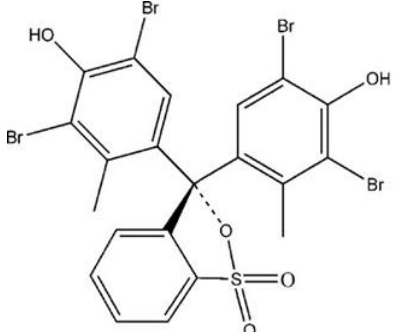
Figure 1. The molecular structure of bromocresol green (BCG) For the purification of the raw clay, 30 g of MMT was dissolved in 1 l deionized water. A mechanical stirrer (250 rpm) agitated the suspension for 24 hours at room temperature (25 ºC) and the solution was then centrifuged (4000 rpm) for 20 minutes. Impurities, such as iron oxide and quartz, due to higher density settled at the bottom of the centrifuge tube. The high purity MMT (located at the upper part of the tube) was subsequently taken, dried at 105 ºC, and sieved to less than 125 μm. 23 In order to modify the clay by